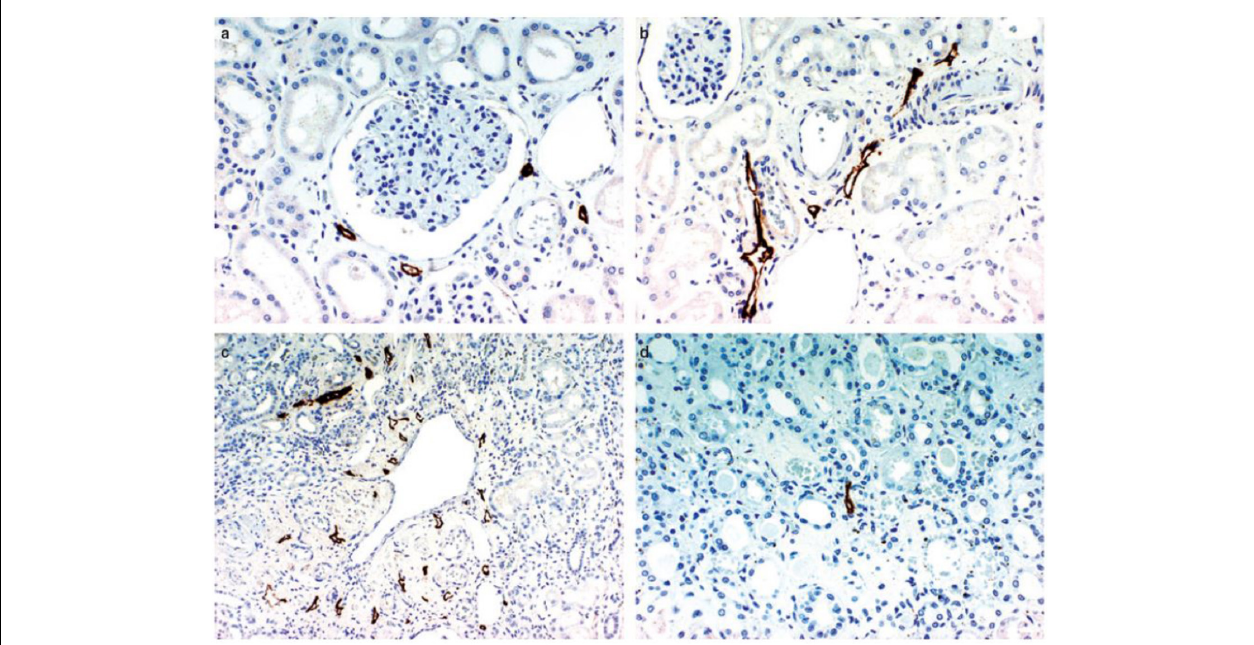
FIGURE 2 | D2-40 immunostaining of lymphatics in the normal kidney. (a) Lymphatic capillaries in the interstitium around the glomerulus, (b) lymphatics exhibiting a slit-like structure are distributed around the interlobular artery and vein in the cortex, (c) multiple lymphatic capillaries in the interstitium around a dilated interlobular vein, a few lymphatic capillaries are present just beneath the venous endothelium, (d) a lymphatic capillary is recognizable in the center of the figure showing a normal medulla. Reproduced with permission from Ishikawa et al. (2006).